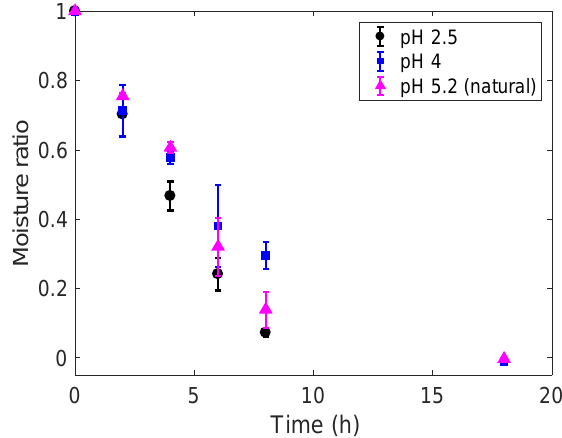
Figure 1. Moisture ratio evolution along time for 2% ( w / w ) gellam gums with pH 2.5 (black dots), pH 4 (blue squares) and pH 5.2 (magenta triangles) loaded with riboflavin during the conducted freeze-drying experiments.